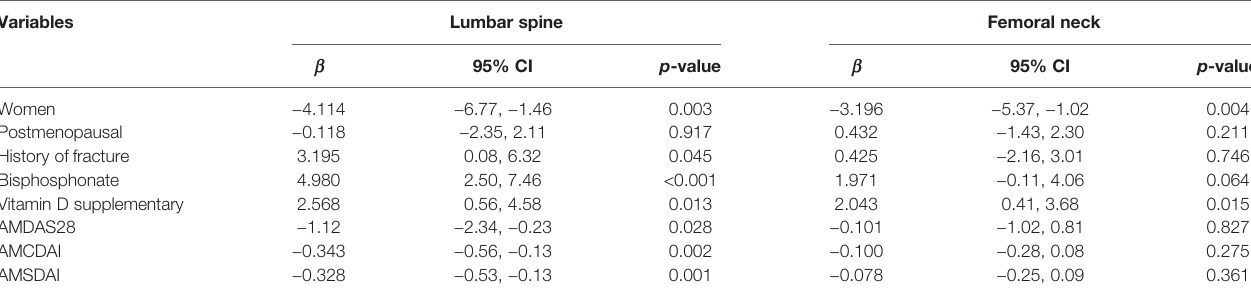
TABLE 4 | In fl uence of a single factor on % D BMD at the lumbar spine during the fi rst year of follow-up: by univariate regression analysis in 144 RA patients.